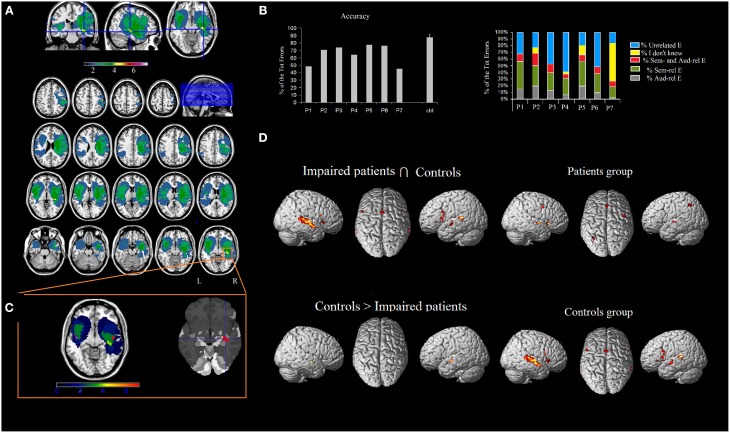
(A) Overlap of the patients' lesions in standard space. MRIcron software (http://www.mccauslandcenter.sc.edu/mricro/mricron/index.html) was used to draw the patients' lesions on their T1 and T2 MRI scans, creating the ROIs which were normalized to the MNI space using the “Clinical Tool box” (http://www.mccauslandcenter.sc.edu/CRNL/clinical-toolbox) for SPM8 (http://www.fil.ion.ucl.ac.uk/spm/software/spm8/). The results highlighted the areas of the brain that are related to the deficit (Karnath et al., 2004). The number of overlapping lesions is illustrated by different colors that code for increasing frequencies (as indicated in the bar code). (B) Patients' pathological performance (mean accuracy) and healthy controls' accuracy and patients' qualitative analysis of errors. (C) The most frequently lesioned area (in bright green-yellow) is the hippocampus/insula/superior temporal gyrus, as shown by the Anatomy toolbox. By using Marsbar (http://marsbar.sourceforge.net/), we drew two ROIs on the two clusters found in the left and in the right STG (which were less activated in patients than controls), shown respectively in pink and in red. The density bar shows that at least 4 out of 7 patients' lesions overlapped with the ROIs drawn on the STG. (D) Network of areas commonly activated in patients and controls and areas differentially recruited by controls vs. patients during ES recognition in addition to the network for ES processing in patients and controls. Activations were superimposed on a brain template provided by spm5.